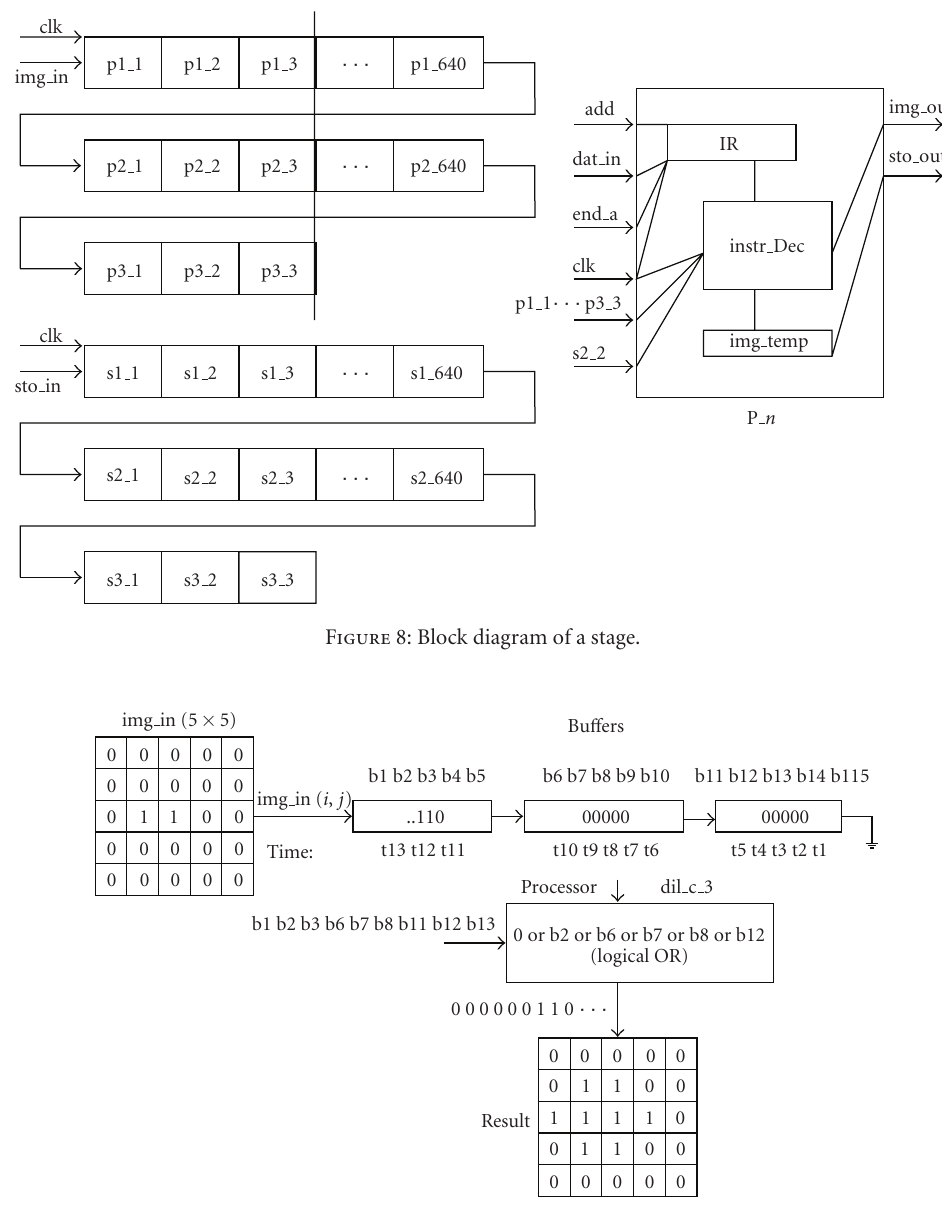
Figure 9: Implementation idea of the proposed